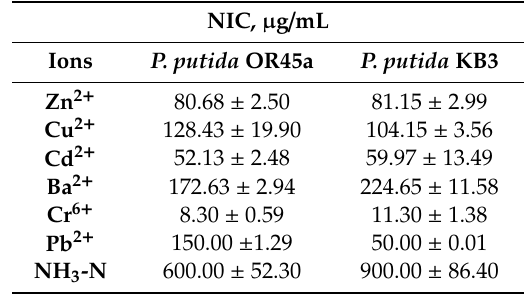
Table 4. The non-inhibitory concentration (NIC) of the selected ions for P. putida OR45a and P. putida KB3. Ions P. putida NIC, µg/ml